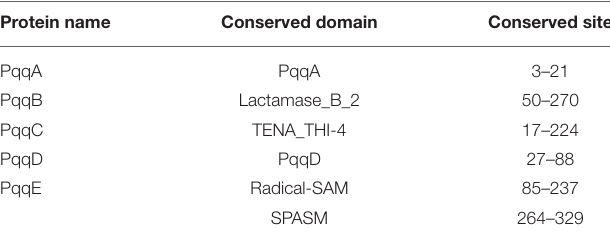
TABLE 1 | Conserved domains and conserved sites present in PqqA–PqqE protein